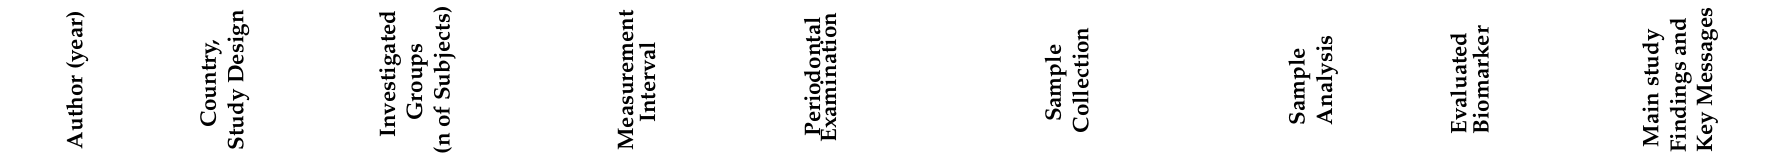
Table 4. Differences in inflammatory responses in oral biofilm between pregnant and non-pregnant women with